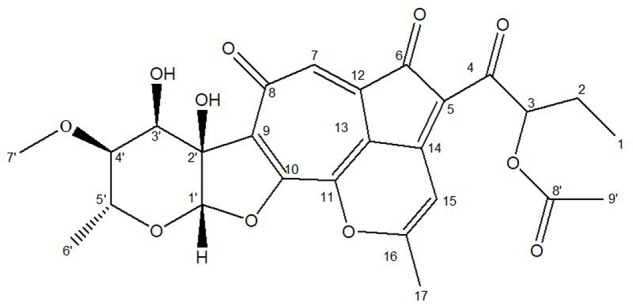
Chemical structure of acetylated Isatropolone C.